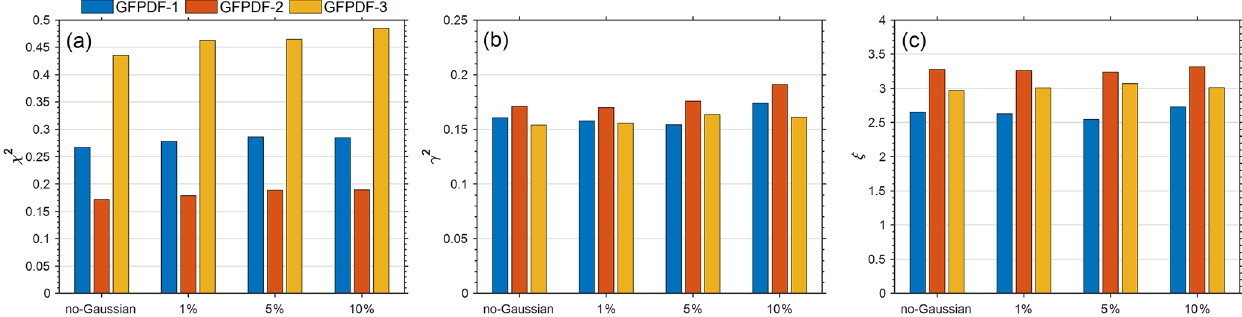
Figure 3. Comparison of reconstruction residual, χ 2 (a) , the GF-PDF error, γ 2 (b) , and the degree of smoothing, ξ (c) of GF-PDFs inverted using Twomey’s methods from synthetic HFIMS data with additional Gaussian noises of different levels (i.e., none, 1%, 5%, and 10%). Colors correspond to the pre-defined GF-PDFs with one mode (blue), two modes (orange), and three modes (yellow). The results are averages based on inversions of 500 sets of synthetic HFIMS data for each of the three pre-defined